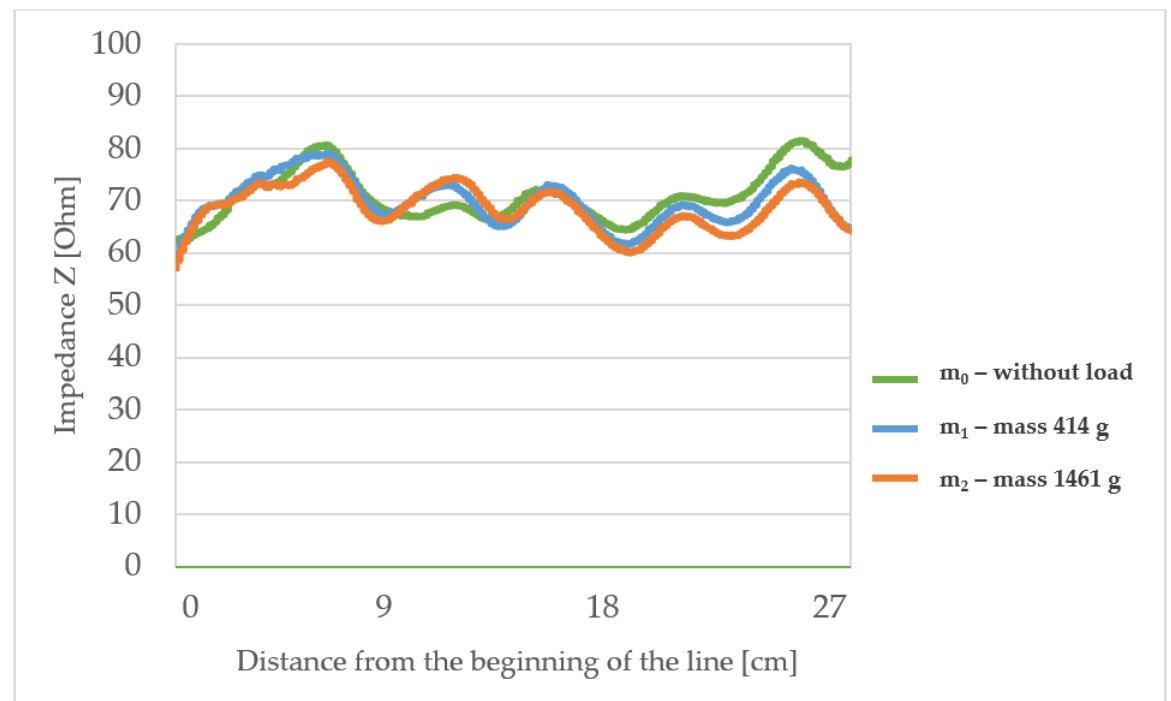
Figure 6. The profiles of the characteristic impedance of the textile signal line L1.